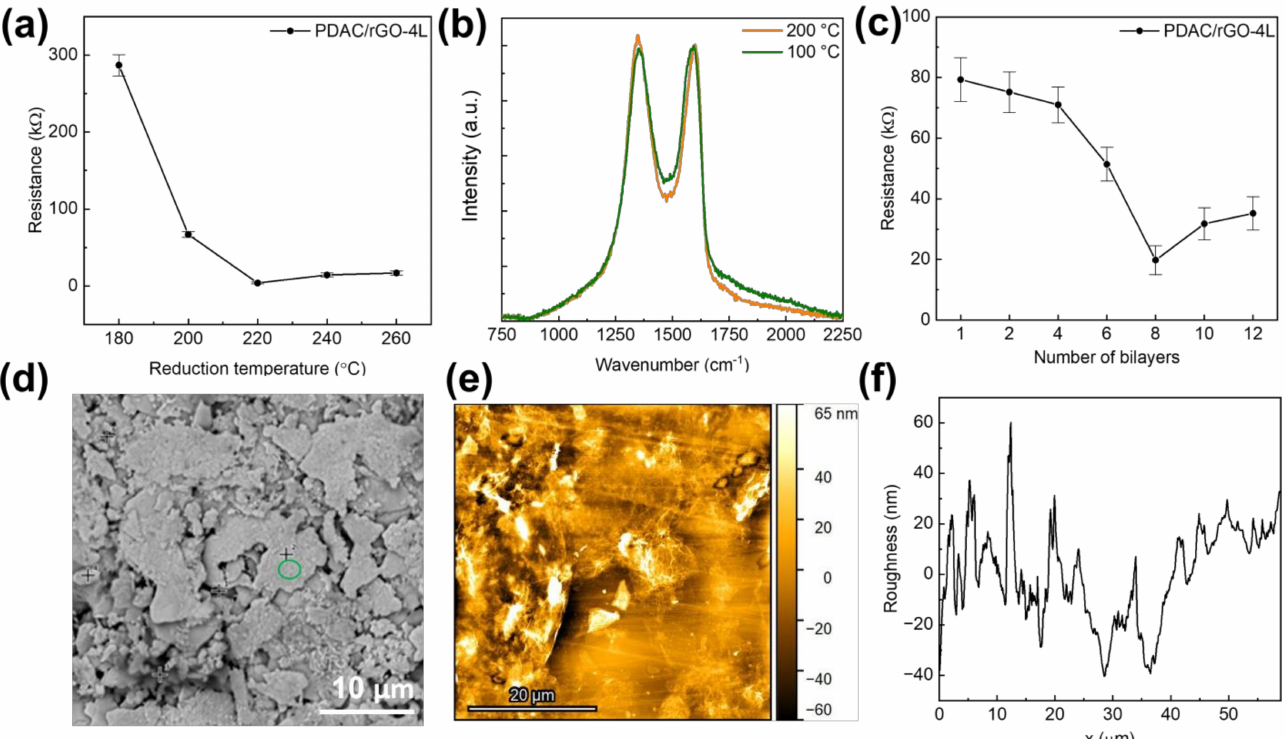
Figure 1. ( a ) Initial resistance of the proposed PDAC/rGO-4L sensors as a function of reduction temperature; ( b ) Raman spectra of PDAC/rGO-4L composite electrodes reduced at 100 ◦ C and 200 ◦ C (spectra were normalized so that the intensity of the G band is set to 1); ( c ) Initial resistance of the proposed PDAC/rGO sensors as a function of the number of deposited bi-layers; ( d ) Low- magnification SEM image showing overall morphology of the sensor; (e) AFM image showing overall topology of PDAC/rGO-2L sensor; ( f ) Roughness profile of the PDAC/rGO-2L sensor from AFM